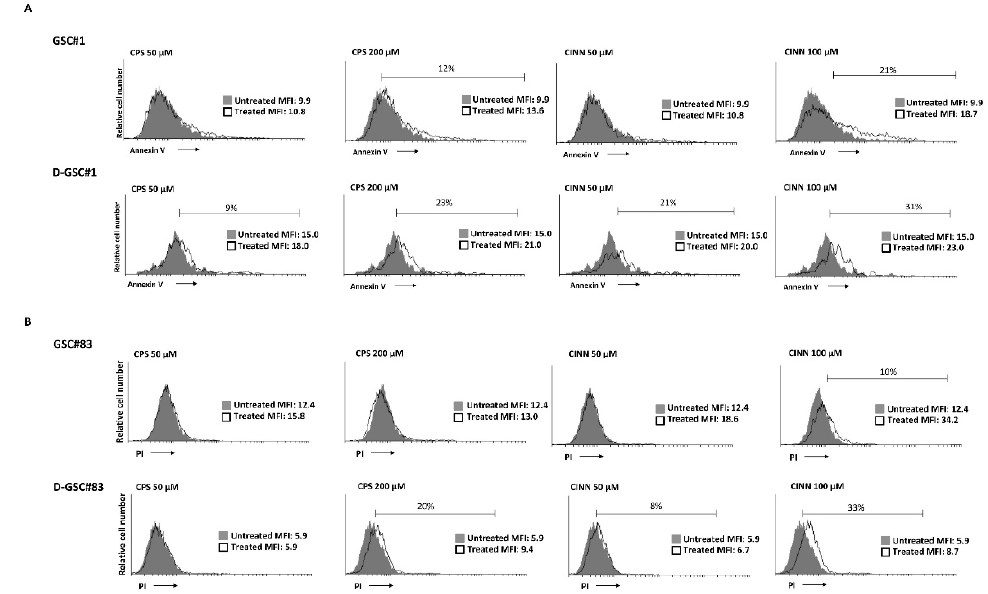
Figure 6. Phenotype characterization of NSCs: ( A ) Annexin V staining was analyzed by flow cytometry in in GSC#1 and D-GSC#1 at 7 days of differentiation, treated with CPS (50 and 200 μ M) or CINN (50 and 100 μ M) for 24 h. A representative one out of three experiments have been shown. Percentages represent the positive cells. MFI = mean fluorescence intensity. ( B ) The cytotoxic e ff ects in GSC#83 and D-GSC#83 at 7 days of differentiation, treated with CPS (50 and 200 μ M) or CINN (50 and 100 μ M) were determined by PI staining and cytofluorimetric analysis assay. A representative of three experiments has been shown. Percentages represent the positive cells. MFI = mean fluorescence intensity.